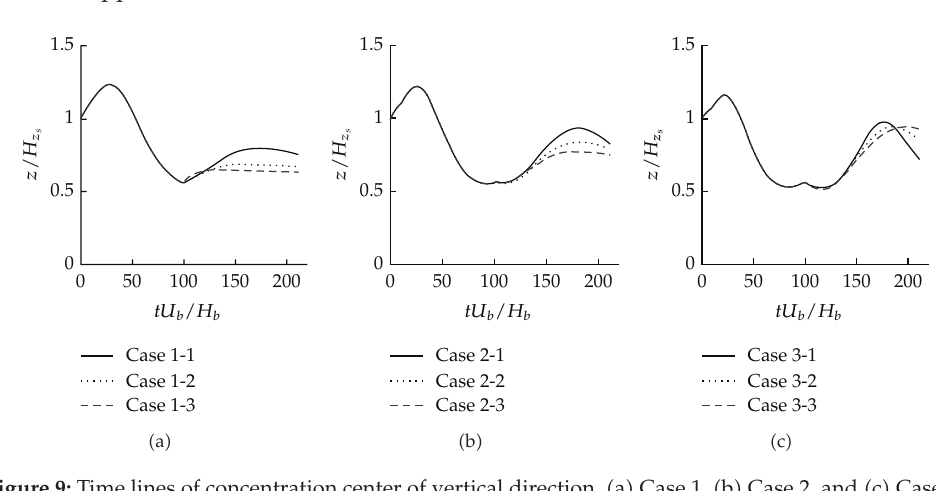
Figure 9: Time lines of concentration center of vertical direction. (cid:3) a (cid:4) Case 1, (cid:3) b (cid:4) Case 2, and (cid:3) c (cid:4) Case 3.